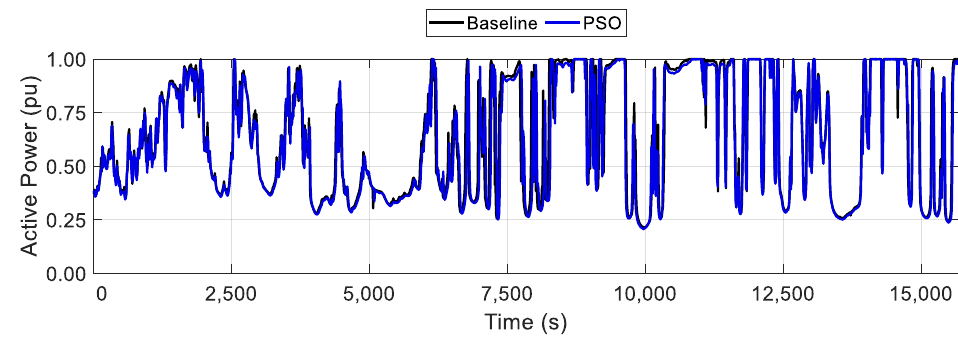
Figure 6. Active Power Comparison Between Baseline and PSO for the Hardware PV Inverter 1.